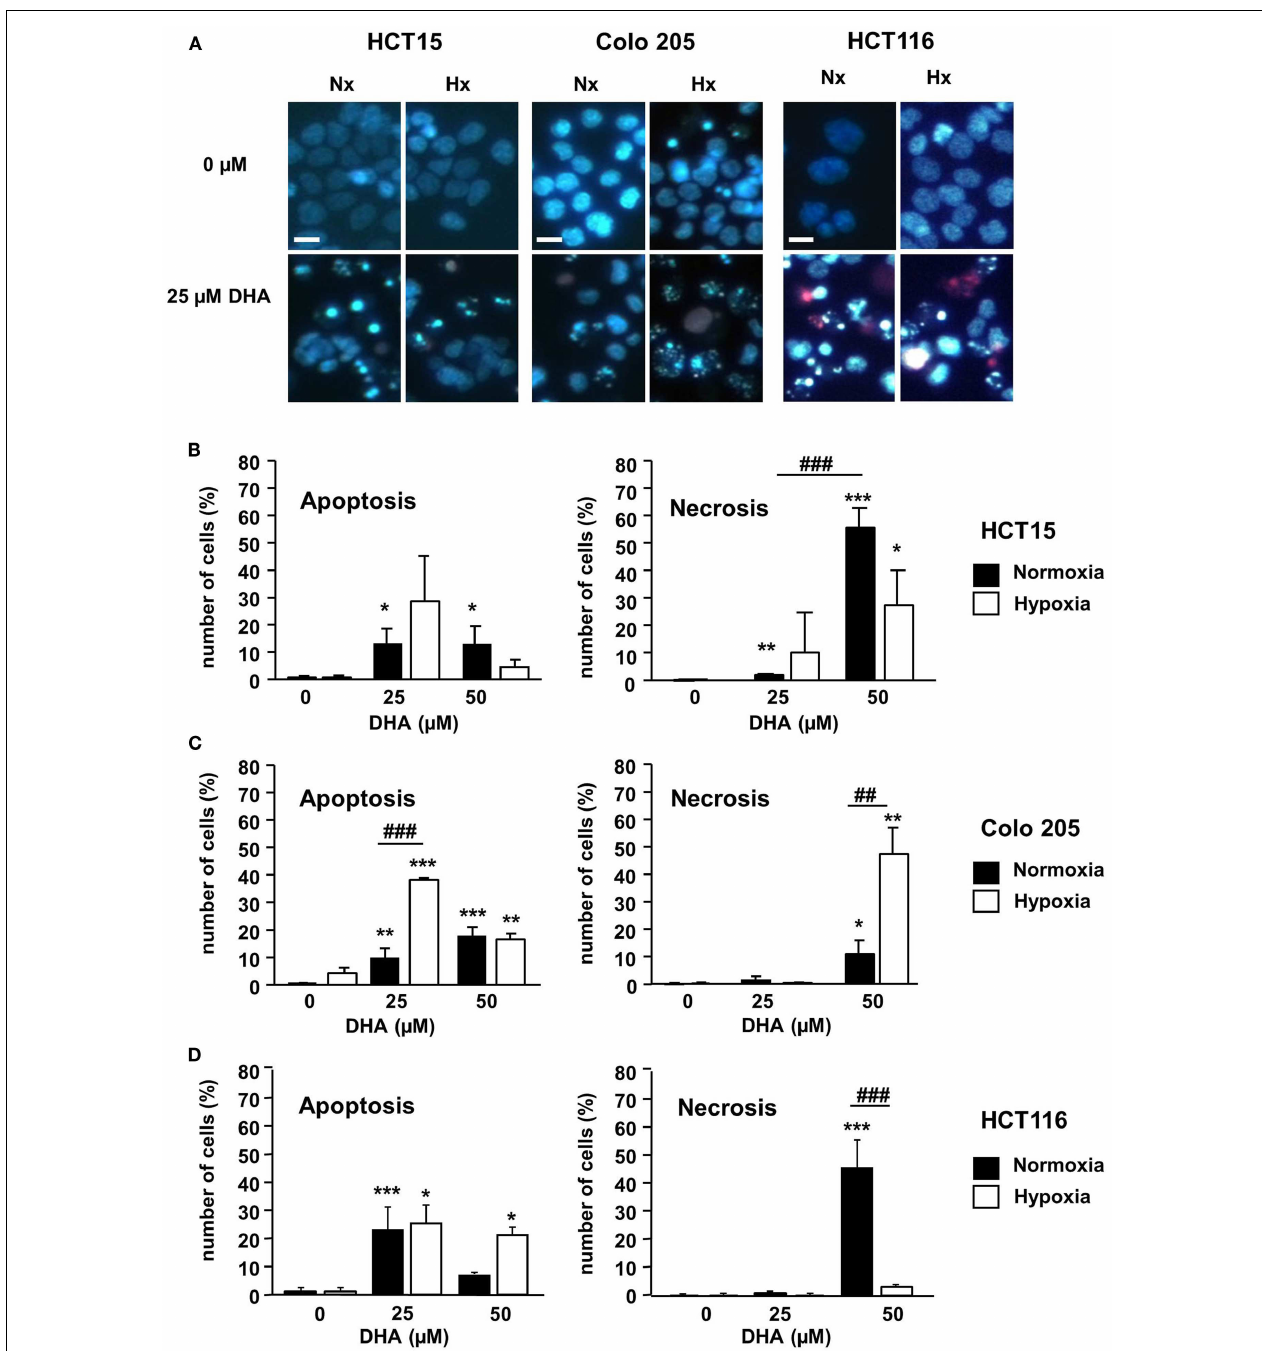
percentage of apoptotic and necrotic cells in (B) HCT15 cells, (C) Colo 205 cells, and (D) HCT116 cells was quantified by counting the fraction of cells with normal, apoptotic, and necrotic nuclei using fluorescence microscopy (DAPI channel). At least 100 cells per field were quantified from three independent areas per condition. Data represent means from three independent experiments ± SD. Statistical analysis was performed according to unpaired two-tailed t -test. * P < 0.05; ** ,## P < 0.01, *** ,### P < 0.001. *Indicates the significance between the solvent treated control cells and DHA-treated cells either in normoxia or hypoxia, # indicates the significance between normoxic and hypoxic cells treated with the same concentration of